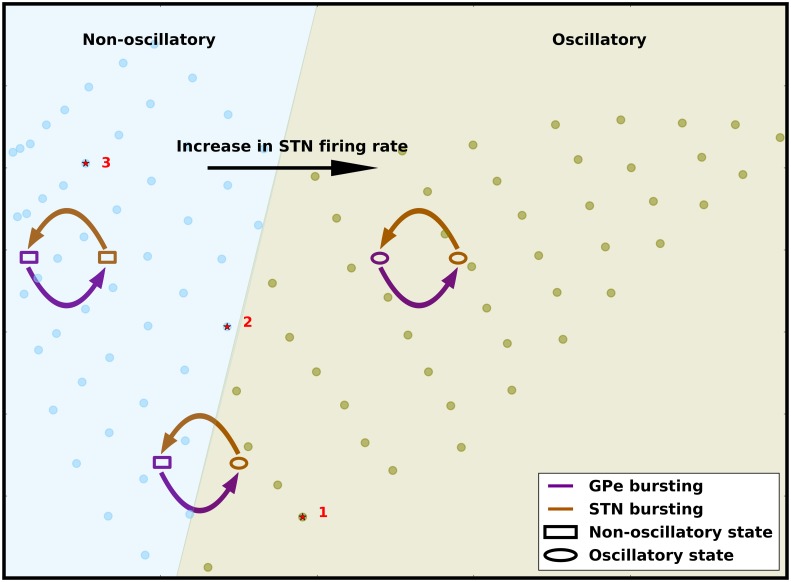
Summary of the effect of firing rate and spike bursting on network state.The background image (same as Fig 7) show the oscillatory and non-oscillatory regimes of STN-GPe network as a function of effective excitation and inhibition. The arrows schematically show the change in EI-balances as we increase spike bursting in the STN or GPe. The STN-GPe network oscillations are more sensitive to the STN firing rate. The balance of STN and GPe firing rates determines the global state of network activity. Spike bursting in GPe always increases both effective inhibition and effective excitation. Small increases in spike bursting in STN results in a decrease in both effective excitation and effective inhibition and thereby, reduces oscillations. By contrast, a large increase in the fraction of spike bursting neurons in the STN increases both effective inhibition and effective excitation and thereby, enhances oscillations. However, this effect is smaller and therefore, spike bursting is effective in altering the network oscillations only when the network is operating close to the border of oscillatory and non-oscillatory states.